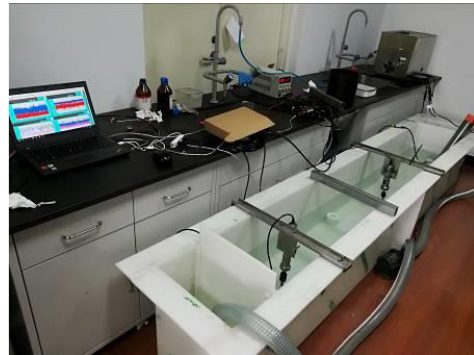
Figure 11. Repeatability test in still water. Table 1. Hydrostatic velocity repeatability test (cm/s).